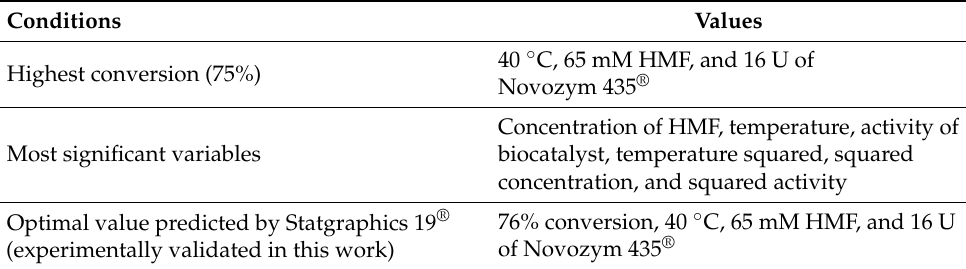
Table 2. Summary of the variables and conditions that maximize the conversion of the reaction to